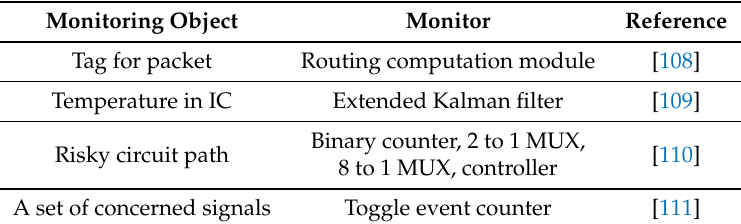
Table 1. Monitoring properties of four